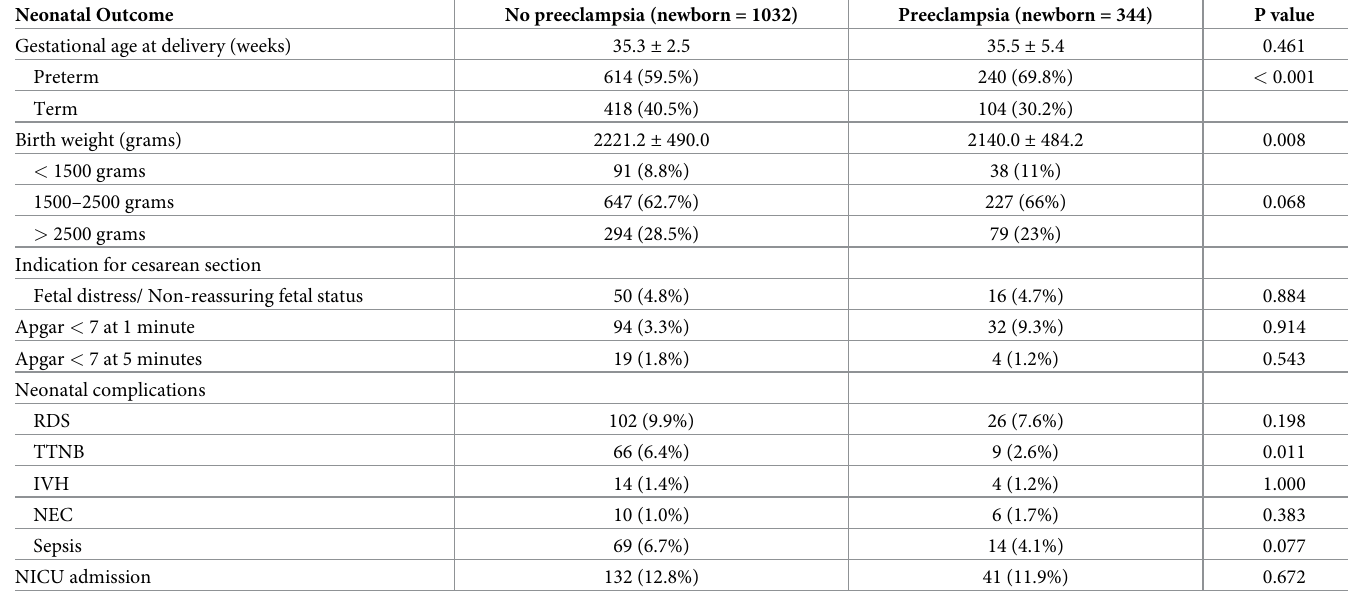
Table 4. Comparison of the neonatal